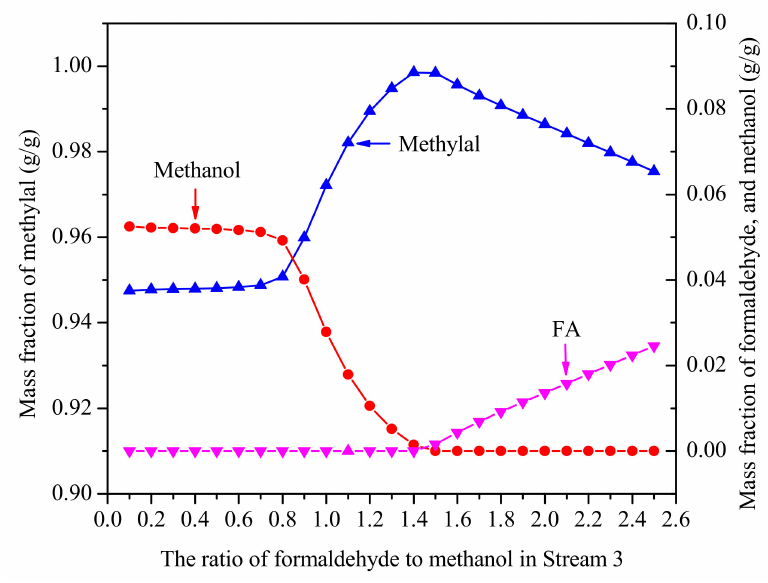
Figure 5. The e ff ect of FA / MeOH ratio on e ffl uent from the top of distillation column. (N = 40, RR = 2, no